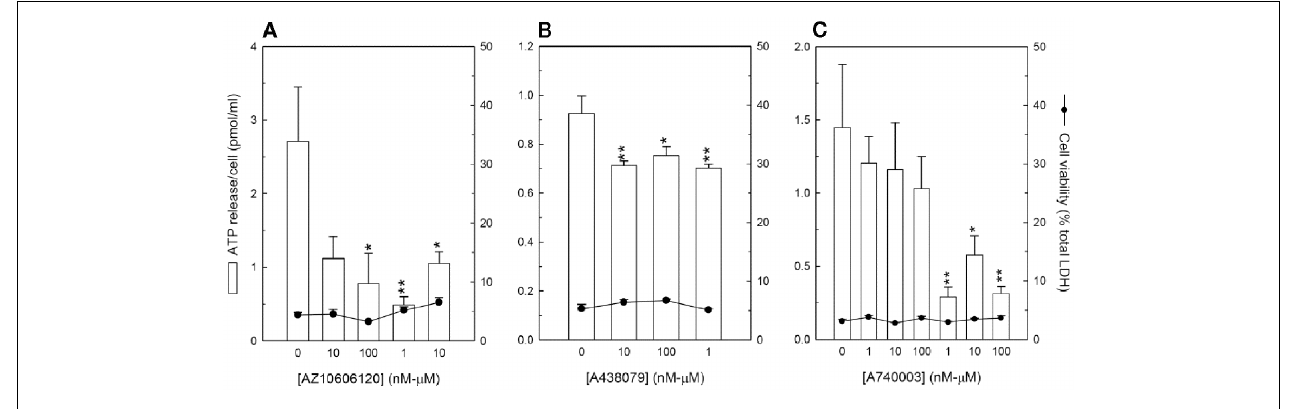
decreased ATP release by up to 80, 25, and 80%, respectively. At the concentrations shown no effects on cell viability were observed.Values are means ± SEM ( n = 12 replicate wells), significantly different from controls: * p < 0.05, ** p <